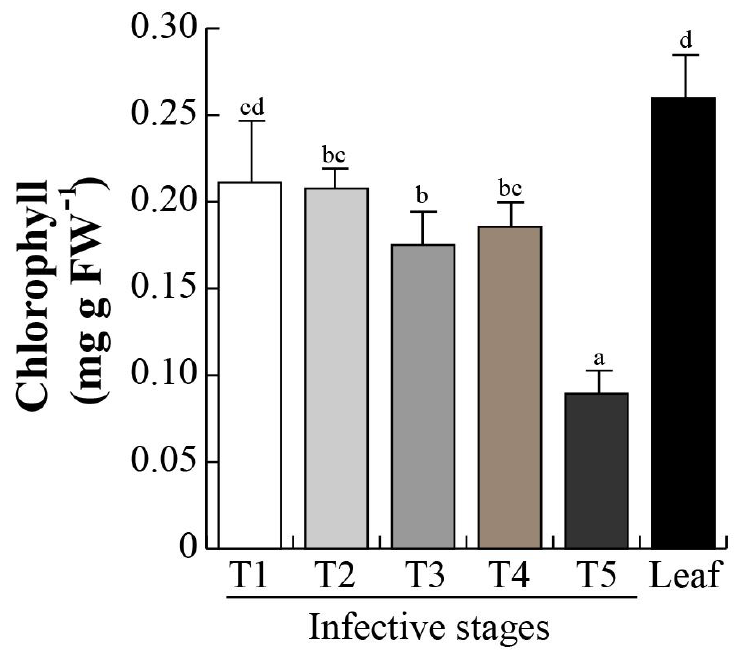
Figure 7. Chlorophyll content of infective stages. The pigment was extracted from each invasive stage. Bars represent mean ± SE (n = 10), different letters above the bars indicate significant differences among infective stages ( p < 0.05 according to ANOVA and Tukey test).